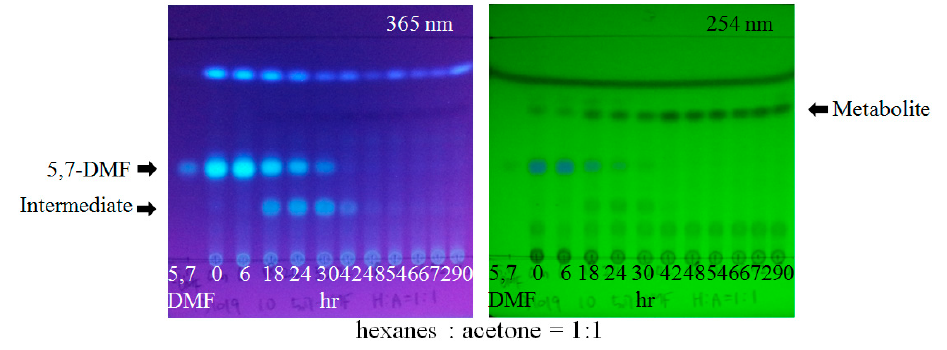
Figure 5. TLC analysis of the metabolites by Blautia sp. MRG-MPF1. The substrate, 5,7-dimethoxyflavone (5,7-DMF), was converted to metabolite, chrysin, via the intermediate later identified as 7-hydroxy-5-methoxyflavone.